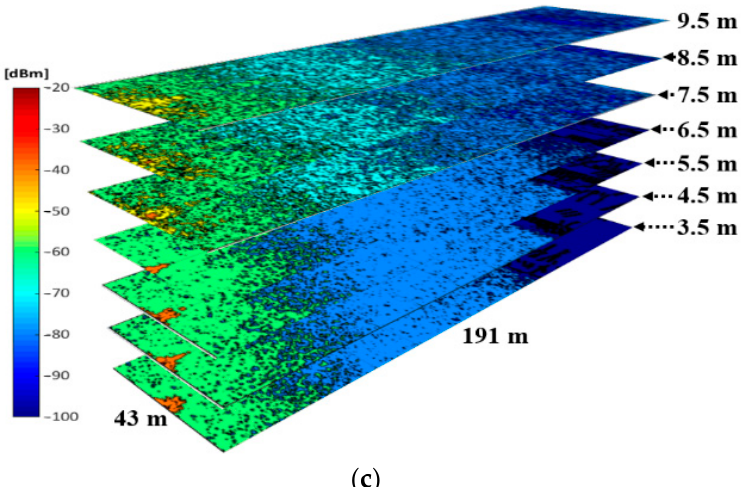
Figure 7. Estimated 2D planes of the received power level at different heights: ( a ) Lateral view of the created scenario; ( b ) Cut planes (XY) in the 975 MHz band; ( c ) Cut planes (XY) in the 2.4 GHz band.